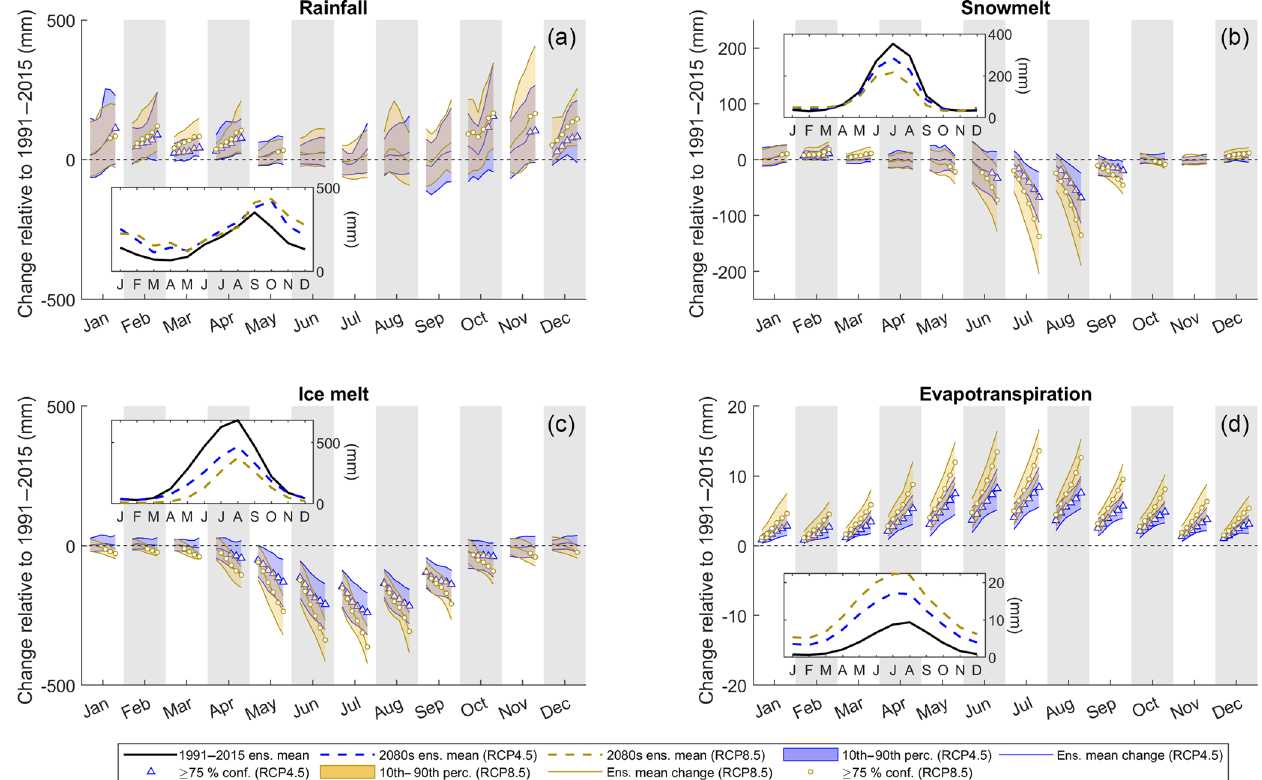
Figure 11. Projections of monthly mean runoff components including rainfall (a) , snowmelt (b) , ice melt (c) , and evapotranspiration (d) for RCP4.5 (blue) and RCP8.5 (yellow). For each month, the trajectory of the ensemble mean change over the 21st century time slices (2030s to 2080s) relative to the reference period (1991–2015) is shown by the solid coloured lines. These lines are marked for each time slice where there is ≥ 75% confidence in the direction of change. They are bounded by the 10th and 90th percentiles of the projections (bands). Inset in each plot are ensemble mean monthly runoff volumes averaged over the reference period (black solid line) and 2080s (dashed